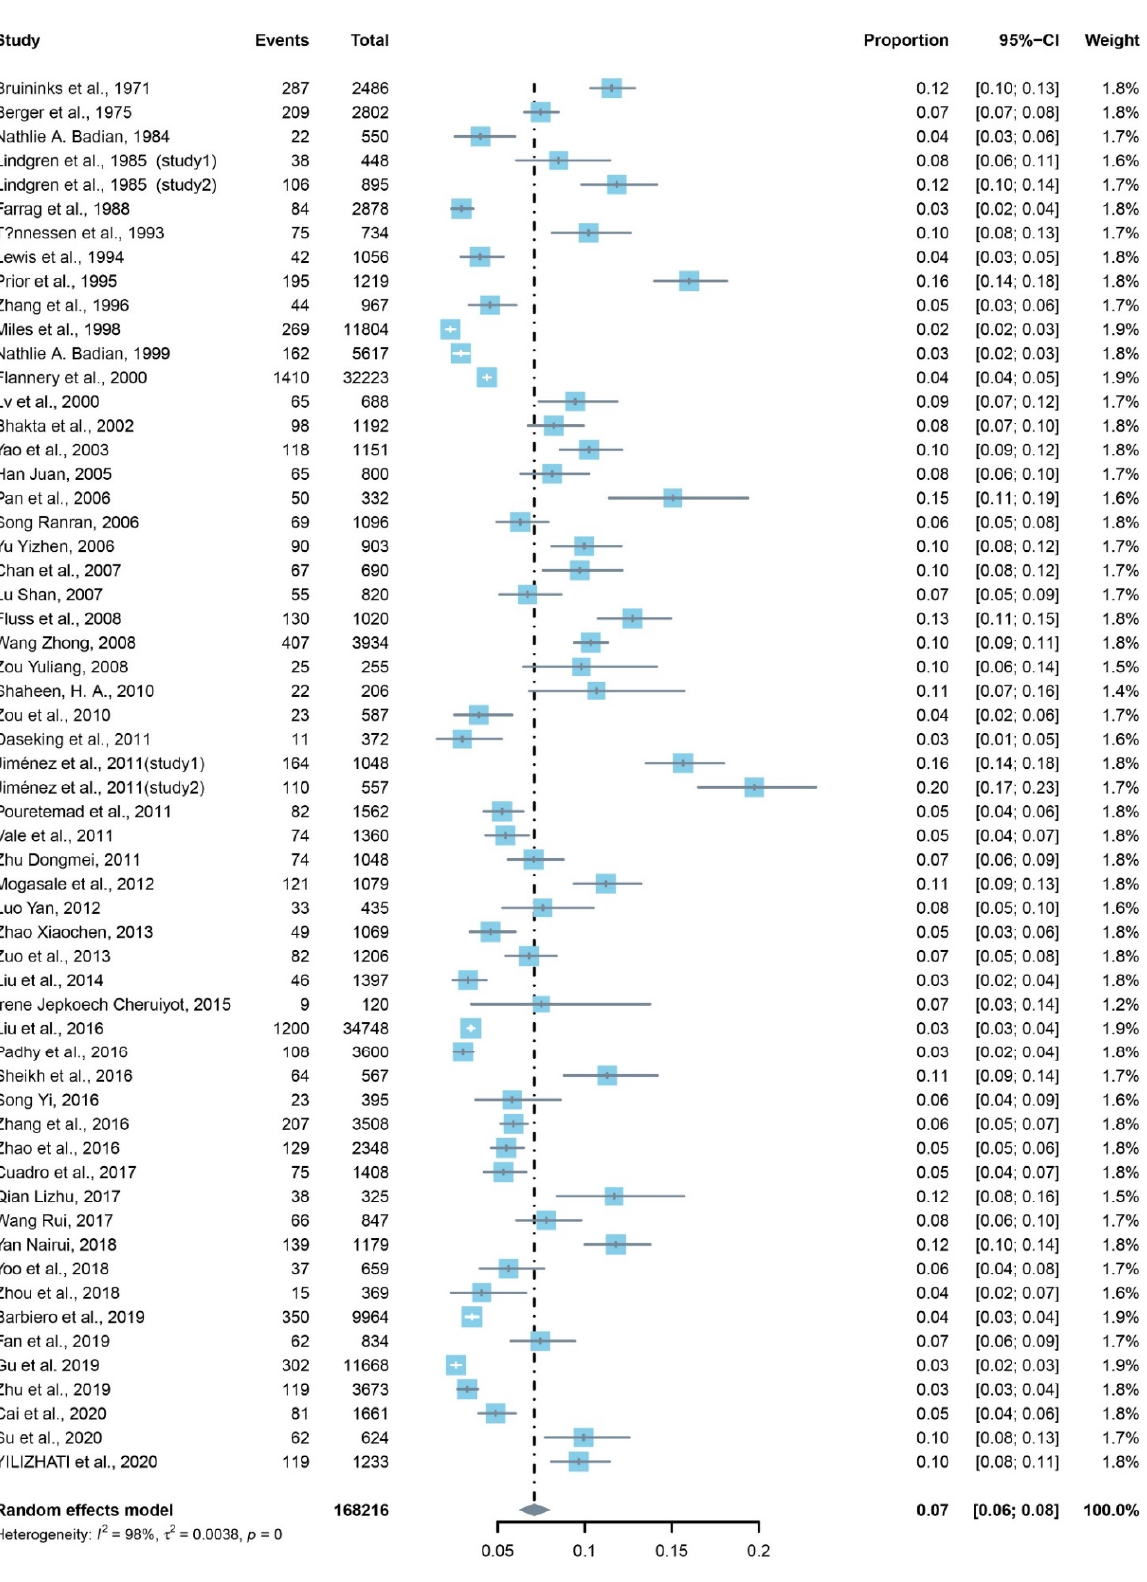
Figure 2. Forest plot for the prevalence of DD using random-effects meta-analysis.